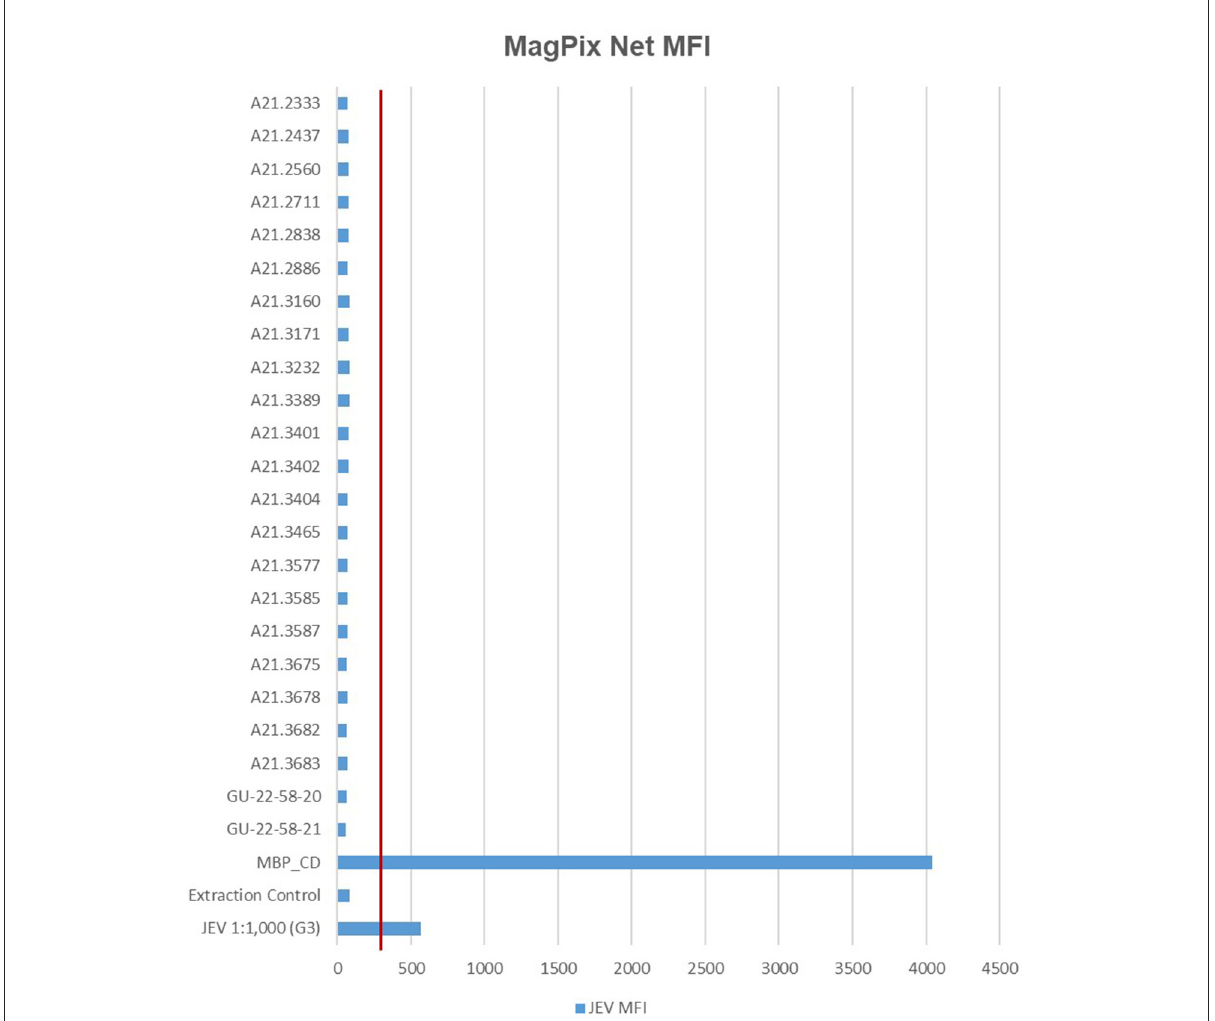
FIGURE1 MFI values for MagPix MultiFLEX ® panel analytes. Red line represents 300 MFI; samples above 300 MFI are positive. Samples labeled A21.xxxx are positive for JEV as determined by RT-PCR. Samples labeled GU-22-58-xx are negative for JEV. JEV 1:1,000 (G3) is an archived sample. Internal Control, Fluorescence Control and Non-specific Binding Control had comparable values between specimen types. MFI, median fluorescent intensity; MBP_CD, positive